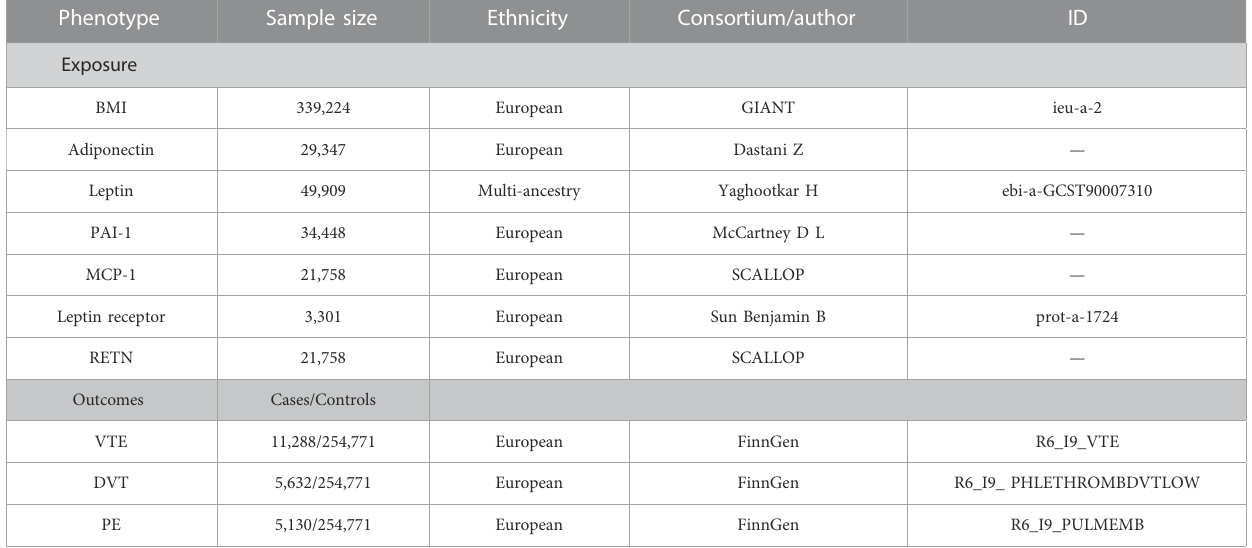
TABLE 1 Details of GWAS included in Mendelian randomization analyses. BMI, body mass index; PAI-1, plasminogen activator inhibitor-1; MCP-1, monocyte chemoattractantprotein-1;RETN,resistin;GIANT,GeneticInvestigationofANthropometricTraits;SCALLOP,SystematicandCombinedAnaLysisofOlinkproteins; VTE, venous thromboembolism; DVT, deep vein thrombosis; PE, pulmonary